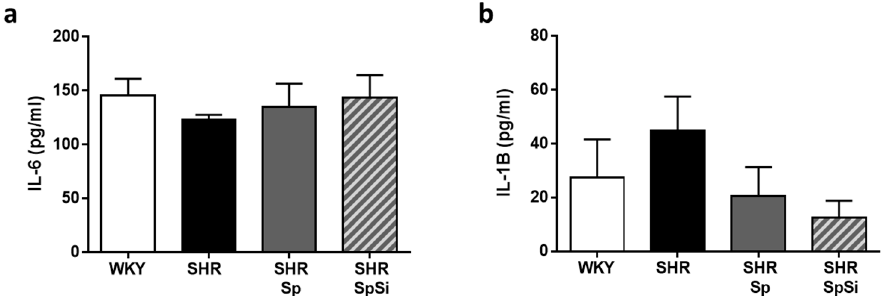
Figure 7. Plasmatic levels of pro-inflammatory cytokines. IL-6 ( a ) and IL-1 β ( b ) were quantified in plasma. Data are expressed as mean ± s.e.m ( n = 15).